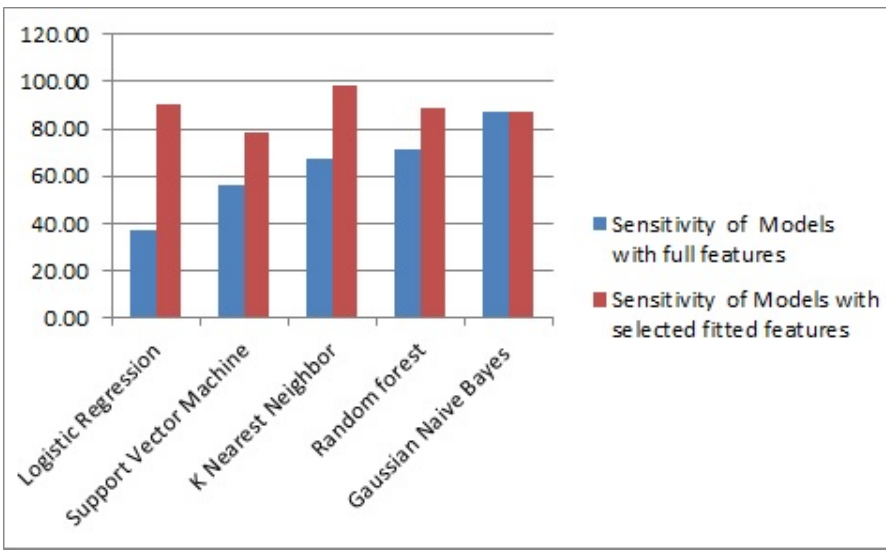
Figure 11. Chart presentation of the sensitivity of the classification models with full features against that of the models with selected fittest features.